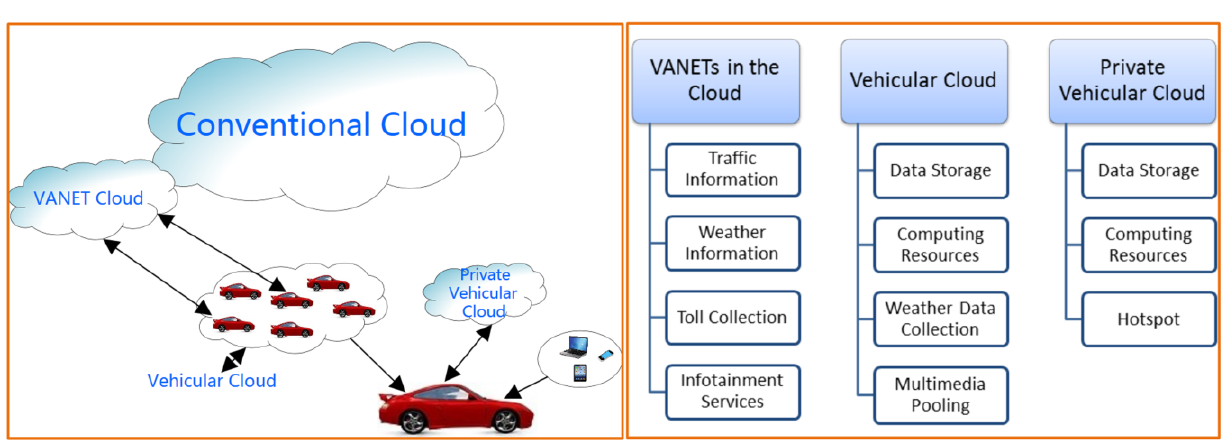
Figure 2. VANETs and cloud (left), cloud applications